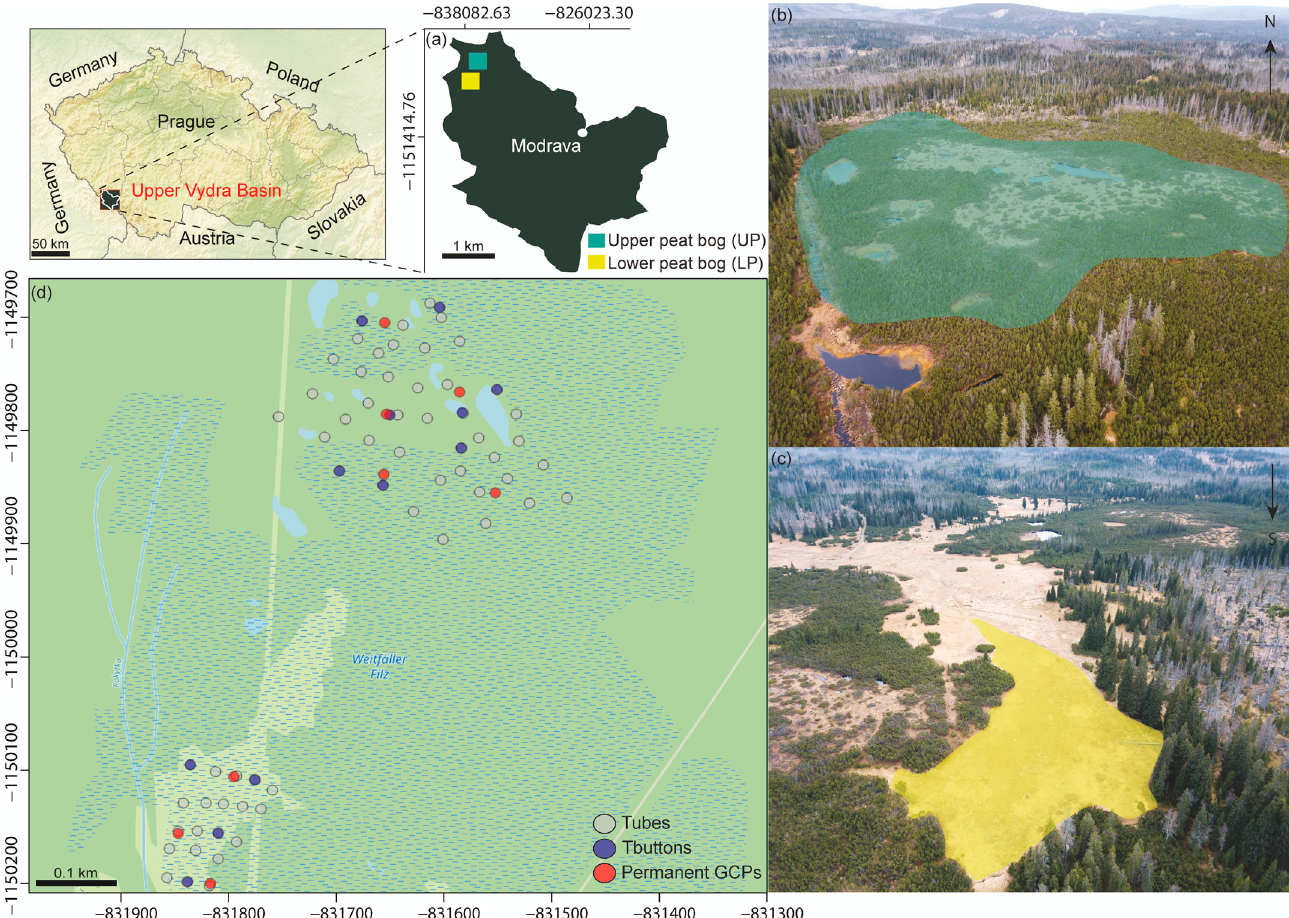
Figure 1. Map of study area ( a ) showing the upper part (UP) ( b ) and lower part (LP) ( c ) with distributed groundwater level tube positions, Tbuttons, and permanent GCPs ( d ).